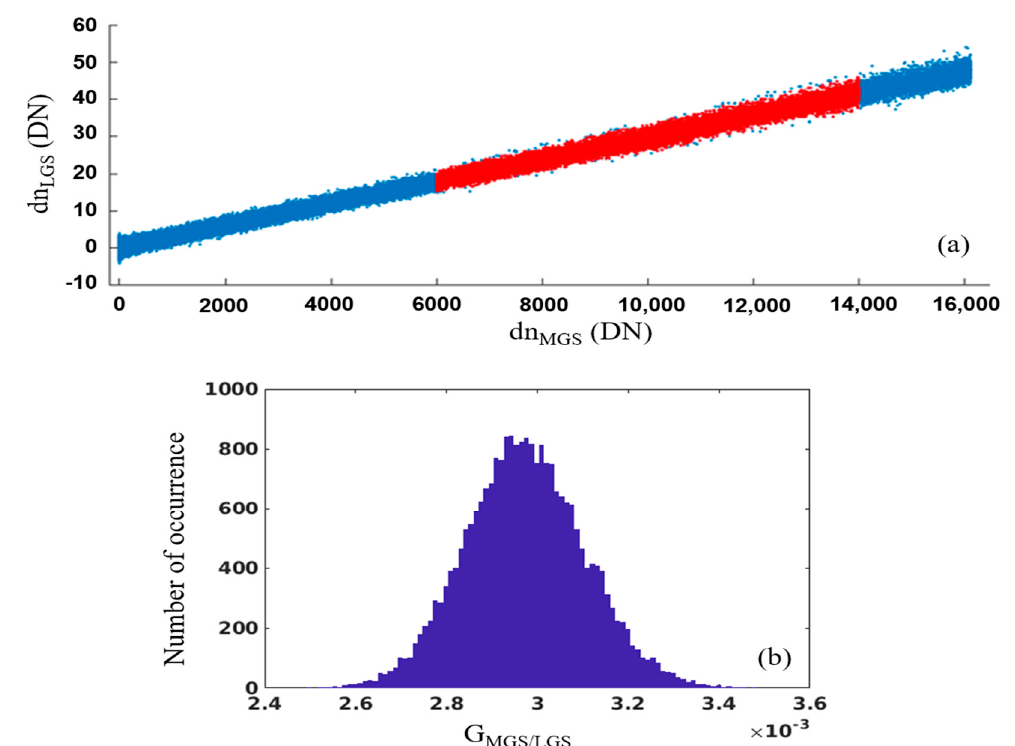
Figure 1. ( a ) Scatter plot of dn LGS and dn MGS collected during a NOAA − 20 VROP between 8:38 and 8:54 UTC on 8 October 2018. The red part is used for G MGS/LGS determination. ( b ) Histogram of the gain ratios calculated by the selected pairs of dn LGS and dn MGS [the red part in (a)] using Equation (6a). Data for aggregation mode 21 and detector 9 are shown.